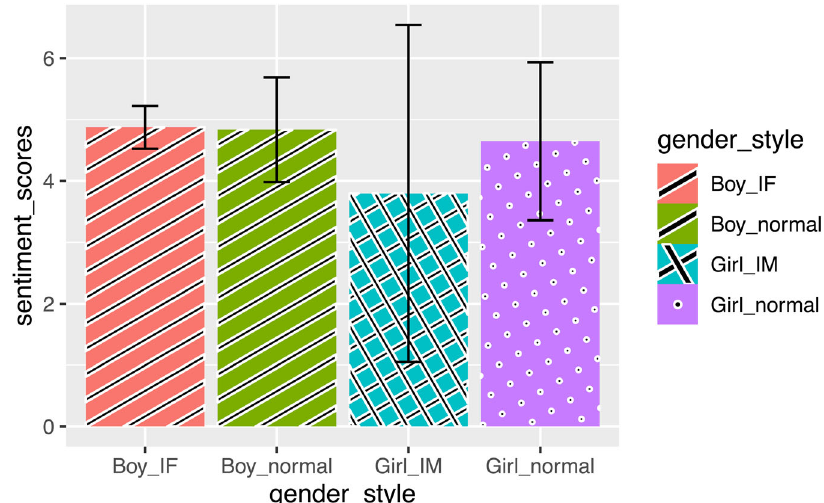
Fig. 5 Sentiment scores in compliments. Both girls and boys exhibited high sentiment scores in their normal compliments. Boys exhibited almost equally high sentiment scores in their imitating tasks compared to their normal speech style. Girls showed substantially lower sentiments when imitating boys ’ compliments than their normal speech styles.